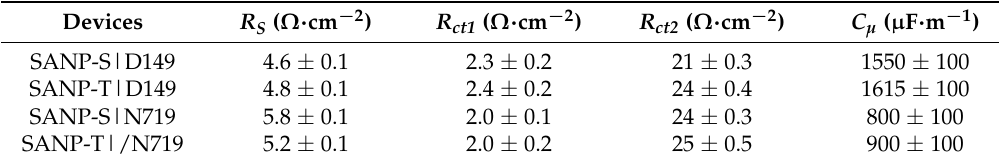
Table 3. EIS parameters of the devices based on SANP-S and SANP-T sensitised with D149 or N719, where R s is the series resistance, R ct 1 and R ct 2 are the charge transfer resistance of the mediator at the counter and in the working electrode respectively, and CPE 1 and CPE 2 are the constant phase elements associated with the counter and working electrodes, respectively [32,36].